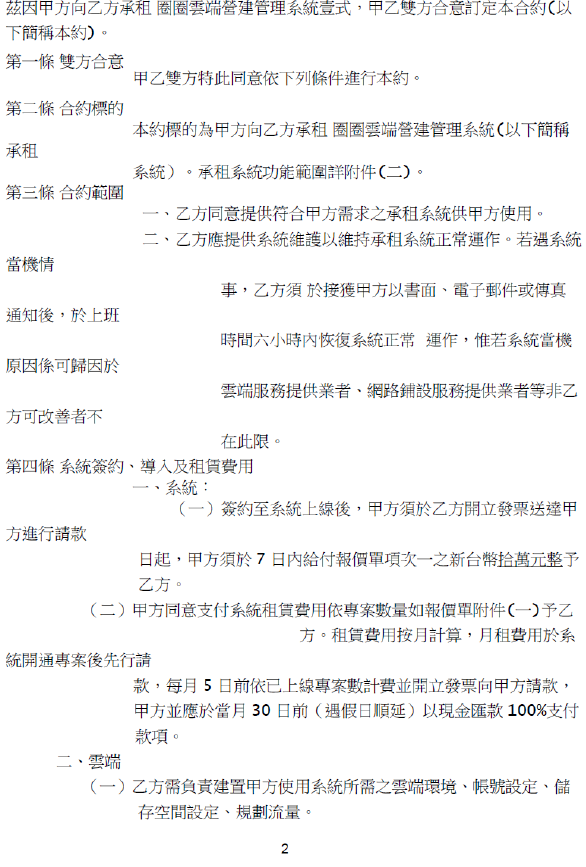
Figure 3. Original text image (A contract stating purposes, scope, and payment methods for IoT platform system service).